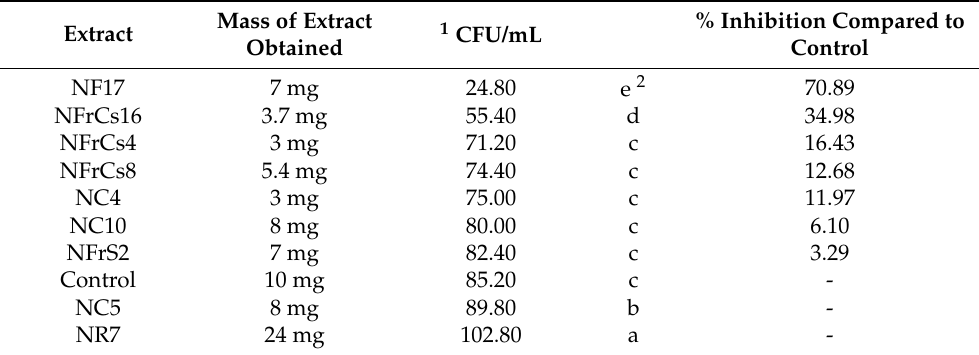
Table 1. Effect of small-scale extracts of endophytic fungi from Morinda citrifolia on the growth of Xanthomonas axonopodis pv. passiflorae